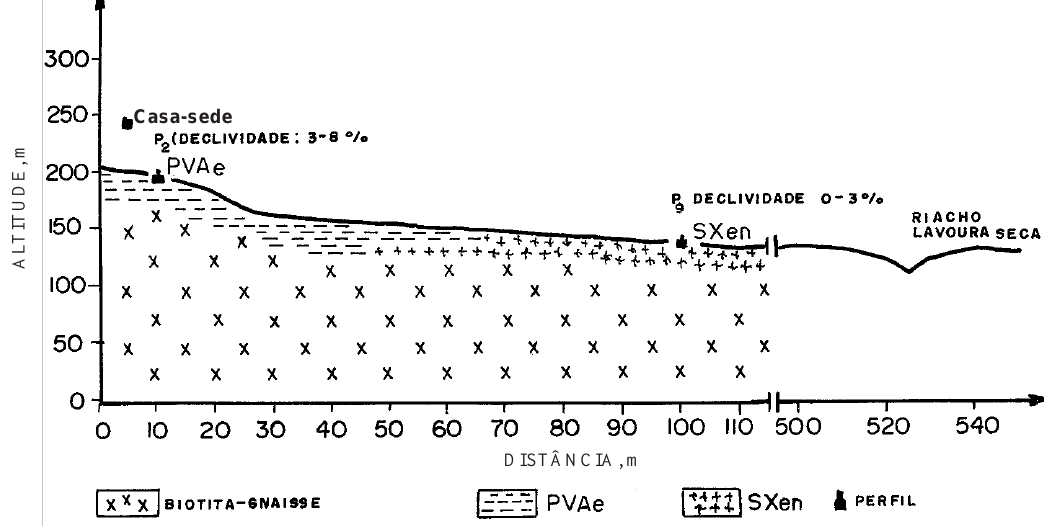
Figura 1. Perfil geológico e topográfico com a localização dos pedons amostrados: perfil 2 (PVAe) e perfil 9